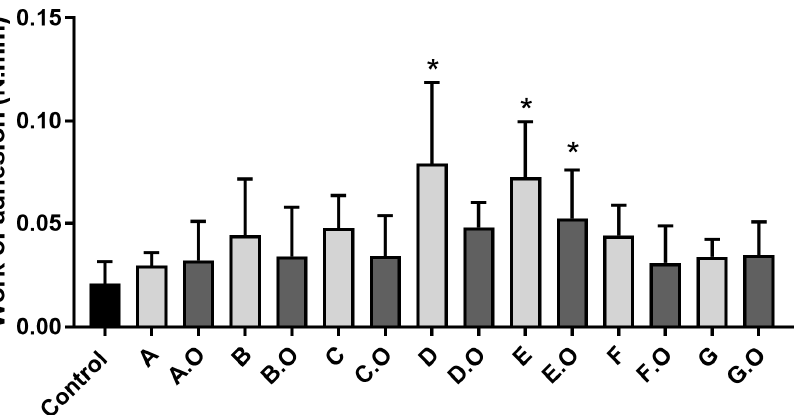
Figure 3. Evaluation of bioadhesive profile of vaginal sheets (work of adhesion (N.mm)). Individual columns and vertical bars represent mean and SD values, respectively (n = 6); * represents statistically significant difference from control ( p < 0.05).